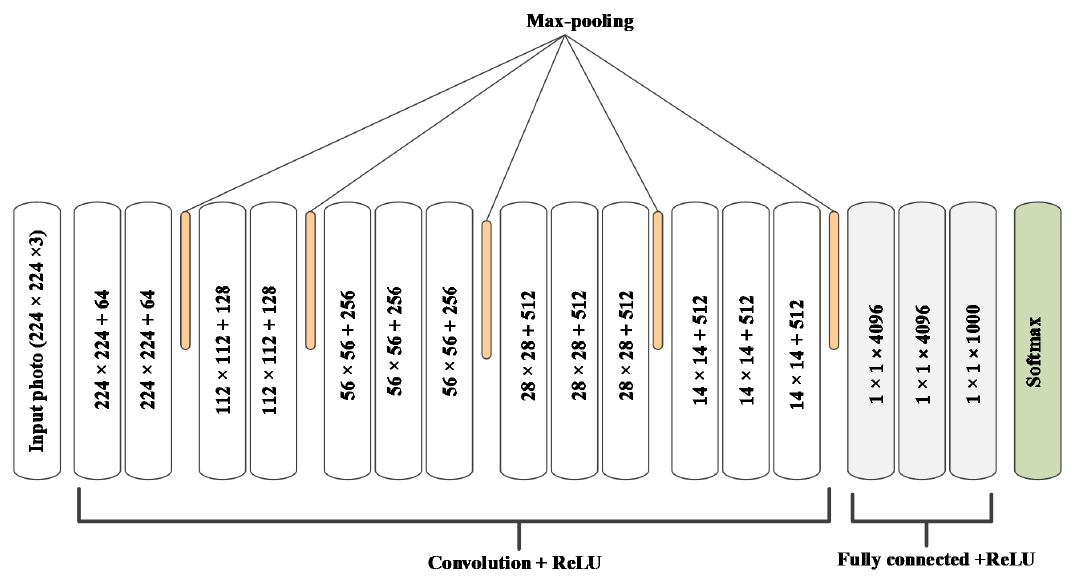
Figure 4. The architecture of VGG-16. The number of feature maps starts at 64 and grows until 512, and filter size is fixed at 3.